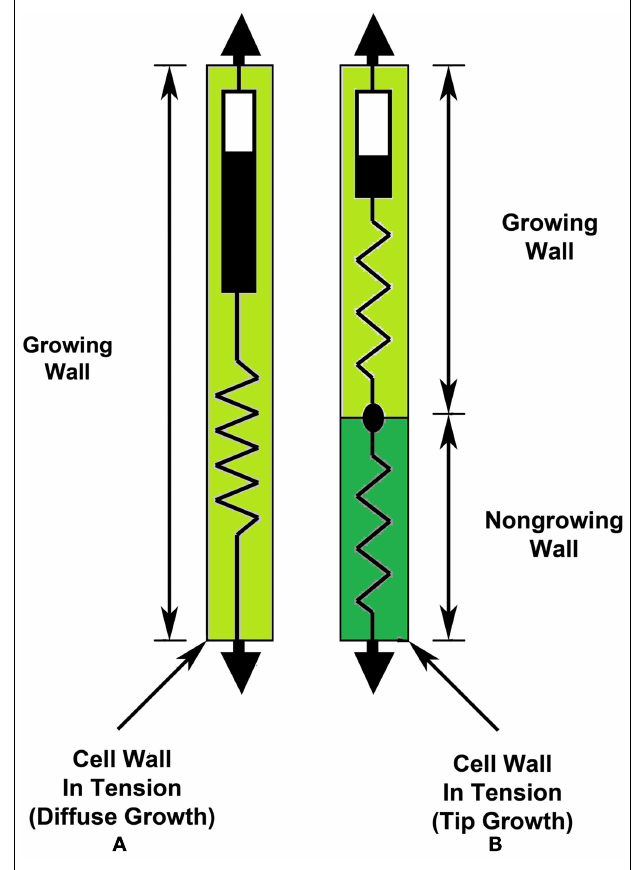
FIGURE 3 | Schematic illustrations of the wall mechanical properties for cells exhibiting “diffuse growth” (A) and “tip growth” (B). The growth zone is light green and non-growing wall is dark green. For diffuse growth (A) , elongation growth occurs over the entire wall that exhibits both irreversible deformation (Bingham dashpot) and elastic deformation (spring). For tip growth (B) , elongation growth only occurs within the growth zone that exhibits both irreversible deformation (Bingham dashpot) and elastic deformation (spring); the non-growing stalk only exhibits elastic deformation